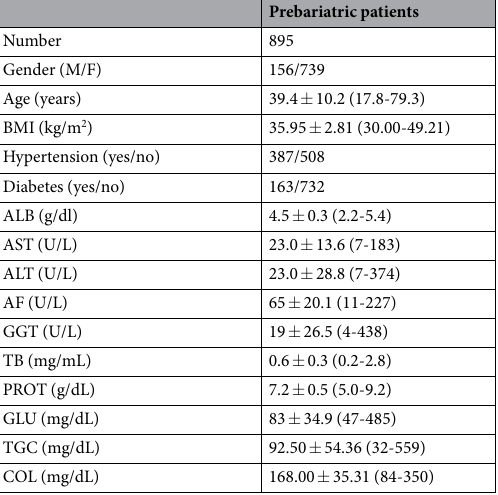
Table 1. Clinical and demographic characteristics of patients included in the retrospective study. Numerical variables are described as median [min. max] and categorical variables as absolute frequencies. M = male. F = female. BMI = body mass index. ALB = plasma albumin. AST = aspartate aminotransferase. ALT = alanine aminotransferase. AF = alkaline phosphatase. GGT = gamma glutamyl transferase. TB = total bilirubin. PROT = total protein. GLU = glucose. TGC = triglyceride. COL = total